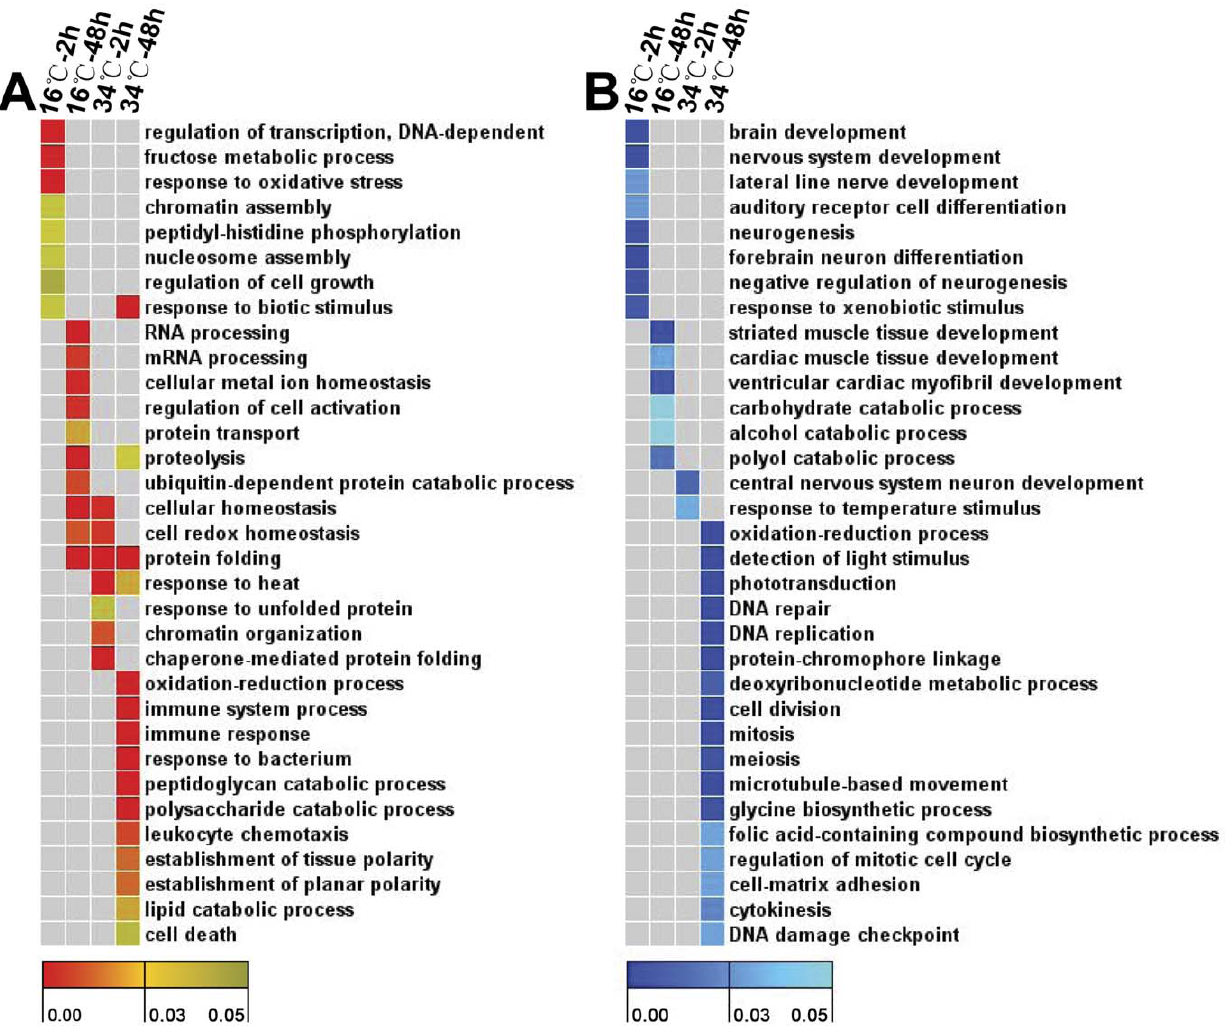
Figure 5. Venn diagrams represent the number of differentially expressed genes. (A) Developmental processes-associated genes under 16, 28 and 34 u C. Differentially expressed genes were identified by comparing their expression in 144 hpf samples (48 h after exposure) to that in 98 hpf samples (2 h after exposure) at the same temperature. ( B ) Temperature stress-regulated genes after 2 h of exposure. Differentially expressed genes were identified by comparing the expression of genes in 16 u C-2 h and 34 u C-2 h samples to that in 28 u C-98 hpf samples. ( C and D ) Overlap between temperature-regulated genes and developmental processes-associated genes. Genes differentially expressed in 16 u C-48 h and 34 u C-48 h samples were compared to the development processes-associated genes identified from larvae maintained at 28 u C?(28 u C-144 hpf vs. 28 u C-98 hpf). The official symbols of genes differentially expressed under different situations were displayed in Table S6.